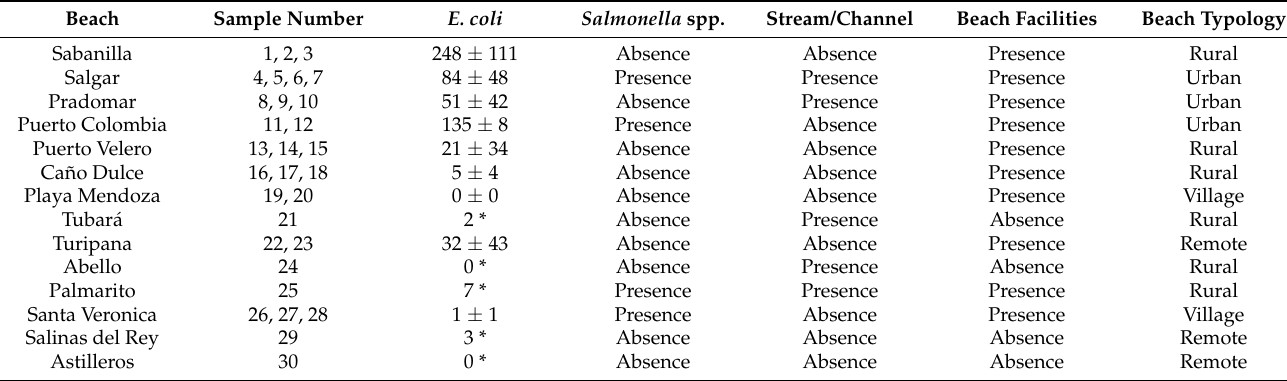
Figure 1. Beaches sampled along the department of Atlántico, Colombia. Table 1. Average values of microbiological parameters and beach characteristics. E. coli counts are expressed in cfu/100 mL. Error is expressed as one standard deviation.